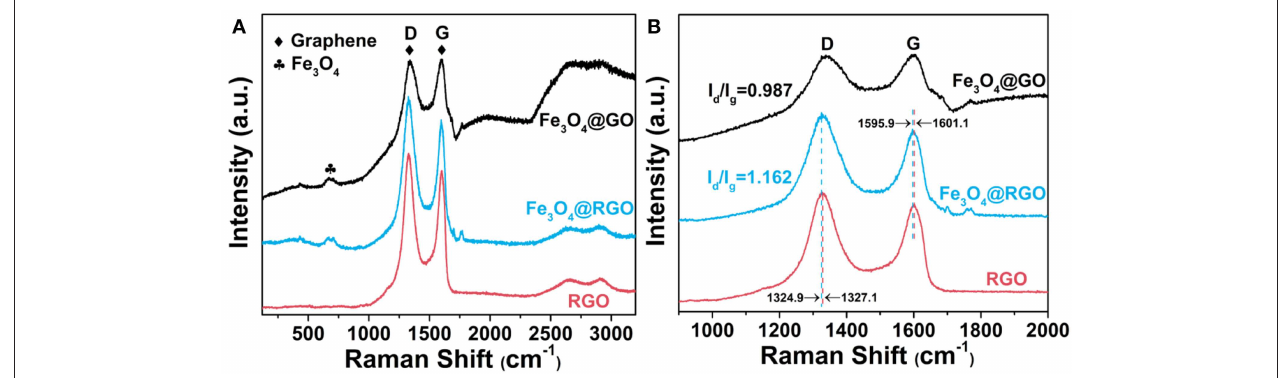
FIGURE 5 | (A) XPS survey spectra of 10wt%-Fe 3 O 4 @GO and 10wt%-Fe 3 O 4 @RGO. (B) High resolution XPS spectrum of Fe 2p of 10wt%-Fe 3 O 4 @RGO. C 1s deconvoluted spectra of (C) 10wt%-Fe 3 O 4 @GO and (D) 10wt%-Fe 3 O 4 @RGO.